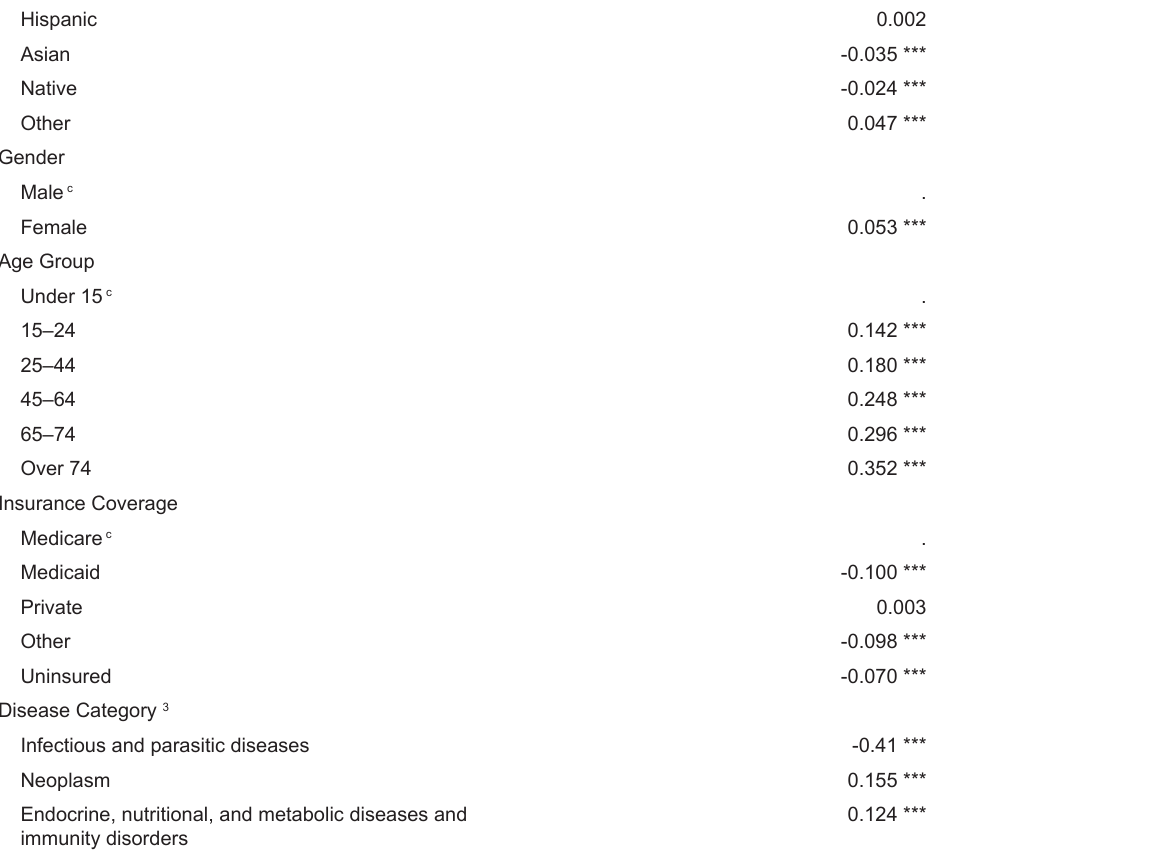
Table 3. Estimated effects of patient and hospital characteristics on duration of routine visits to hospital emergency departments.